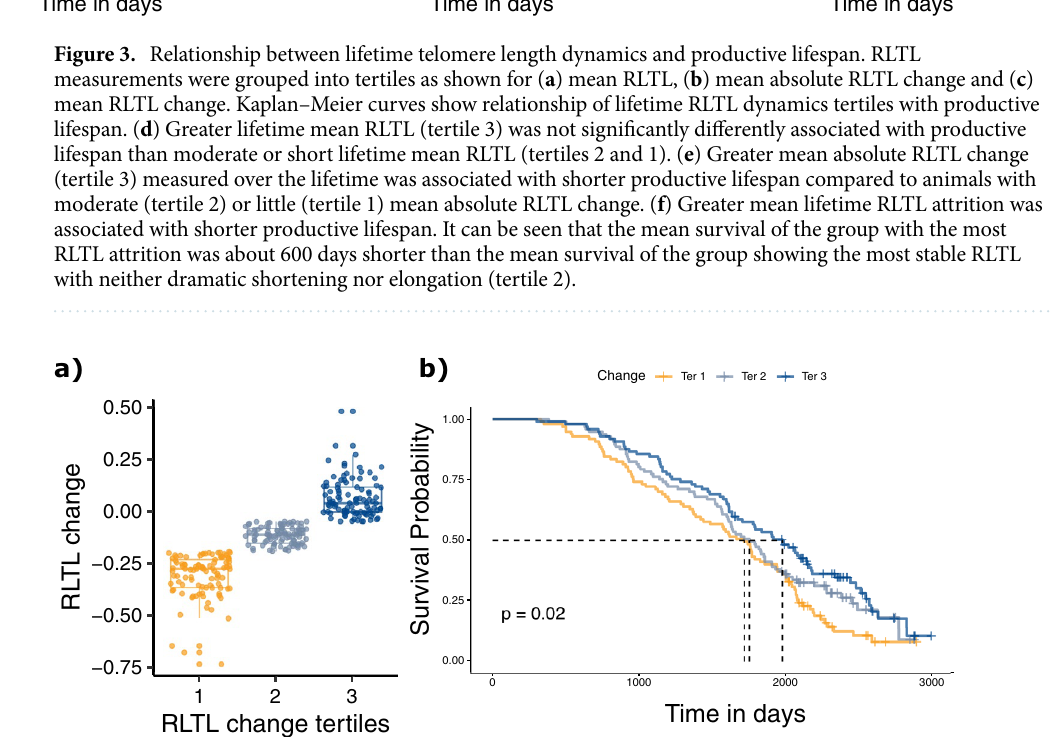
Figure 4. Early-life change in RLTL and productive lifespan. ( a ) visualises how continuous RLTL change measurements were grouped into discrete tertiles to allow visualising of survival data. ( b ) Kaplan–Meier plot that shows the association of early- life RLTL change tertiles with productive lifespan. More RLTL attrition within the first year of life (tertile 1) was associated with a shorter productive